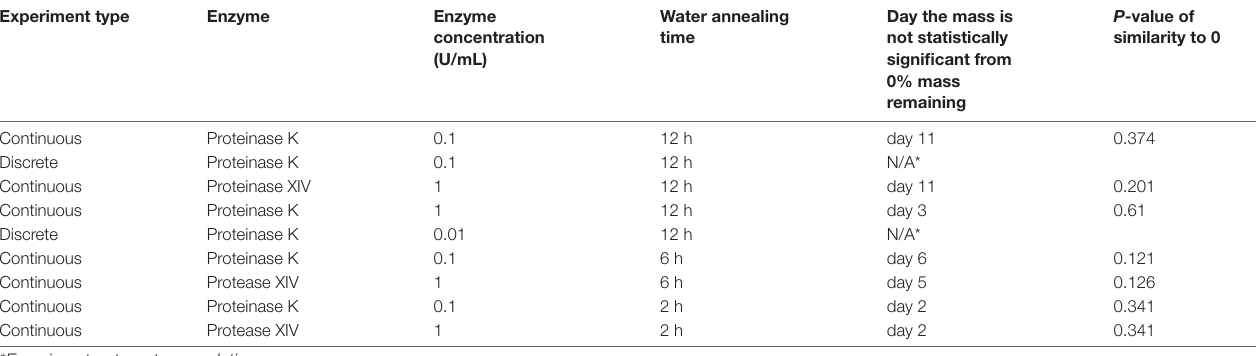
TABLE 2 | The t -test analysis for each experiment with respect to 0% remaining sponge mass. Experiment type